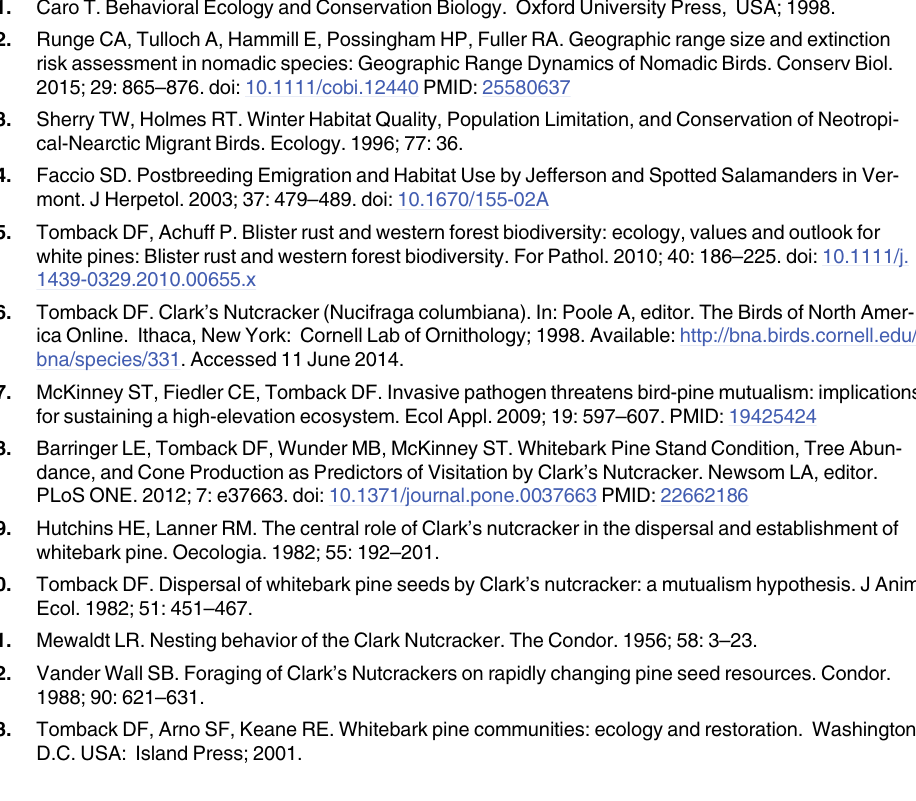
S5 Table. The Manly selectivity measure (± Bonferroni 95% confidence intervals (CI ’ s)) used to evaluate Clark ’ s nutcracker selection of foraging